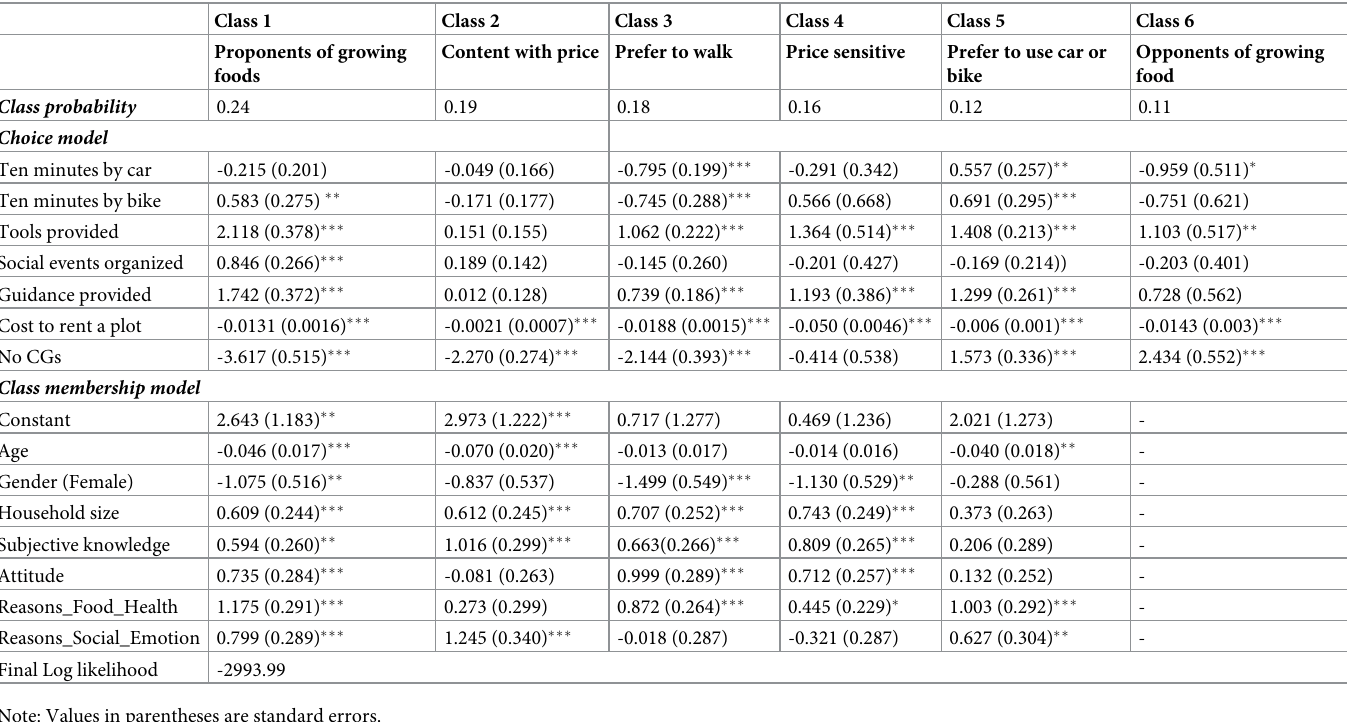
Table 5. Estimation results from latent class